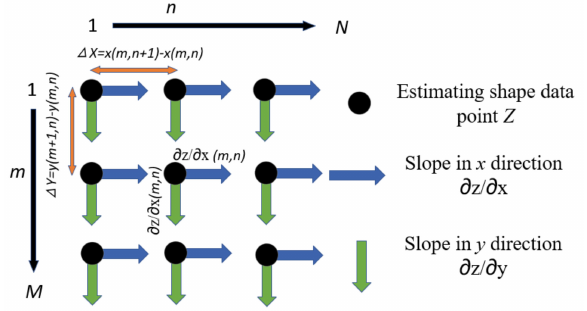
Figure 4. Grid model in 2D